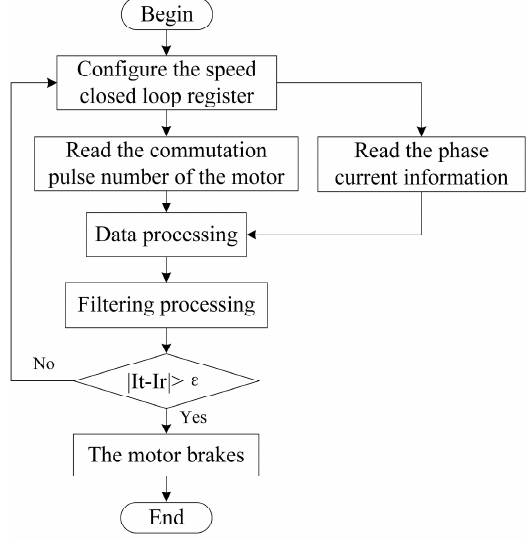
Figure 14. The “current–force–depth” feedback control process.